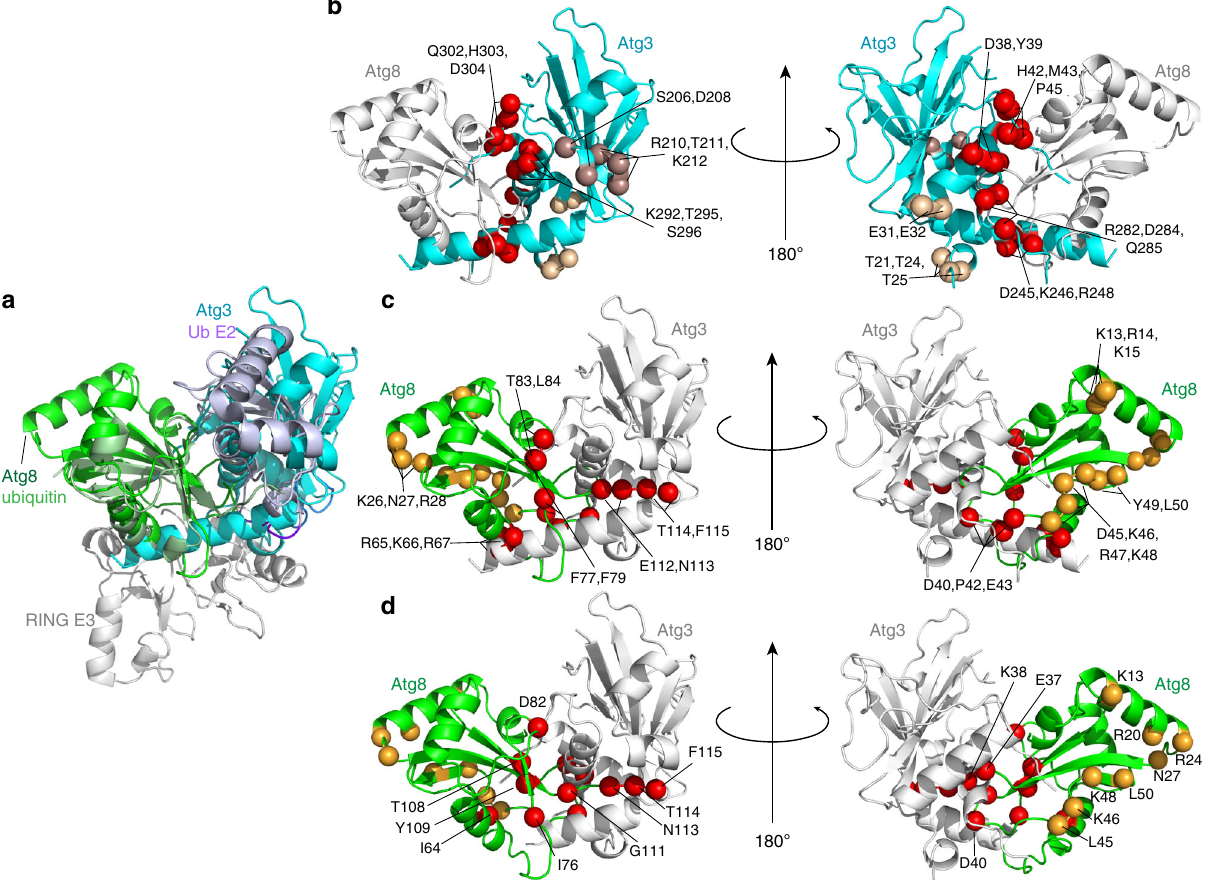
Fig. 8 Modeling of the active conformation of Atg3~Atg8 intermediate. a Generation of model for a potential closed E2~Ubl conformation for Atg3~Atg8, with structures of Atg3 Δ NFR (PDB 6OJJ, from this study) and Atg8 (PDB 2ZPN) superimposed on E2 and Ub, respectively, in a RING E3 – E2 – Ub complex (PDB 4AP4). b Sites of Atg3 mutations impairing E3-dependent activation of Atg3~Atg8, mapped on model for closed conformation. Red — residues corresponding to E2 – Ub interface in closed conformation; wheat — residues corresponding to RING E3-binding site; bronze — residues in catalytic segment. c Sites of Atg8 mutations impairing E3-dependent activation of Atg3~Atg8, mapped on model for closed conformation. Red — residues corresponding to E2 – Ub interface in closed conformation; orange — residues corresponding to AIM/LIR-binding site. d Atg8 residues showing chemical shift perturbation one standard deviation above the mean upon covalent complex formation with Atg3, mapped on model for closed conformation. Red — residues corresponding to E2 – Ub interface in closed conformation; orange — residues corresponding to AIM/LIR-binding